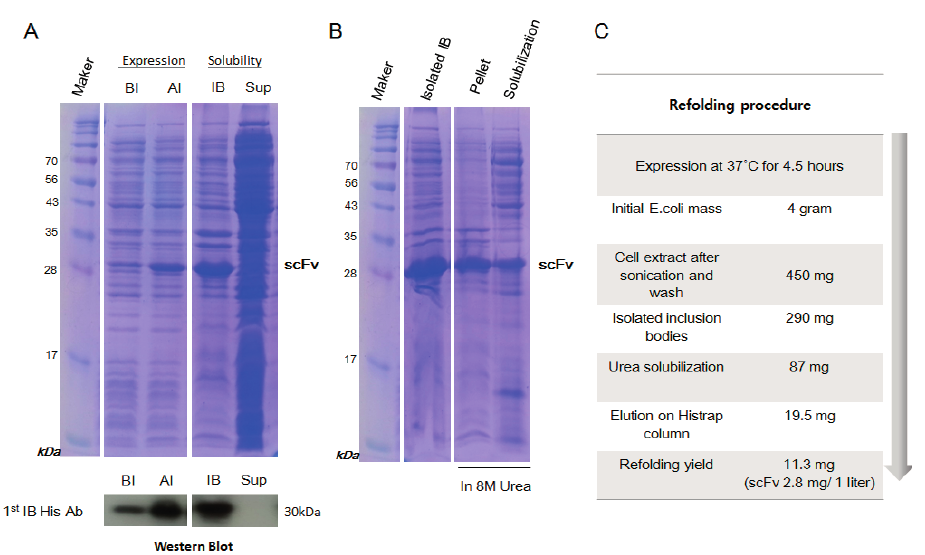
Figure 2. The expression, isolation and solubilization of the scFv protein from E. coli . ( A ) The recombinant scFv showed high expression after IPTG induction (AI), corresponding to 30 kDa in SDS-PAGE ( top ) and Western blot analysis ( bottom ) compared with pre-induction (BI); ( B ) SDS-PAGE analysis of the inclusion bodies (IB). The pellet and the solubilized scFv using 8 M urea were separated by centrifugation; and ( C ) Schematic diagram of the scFv refolding